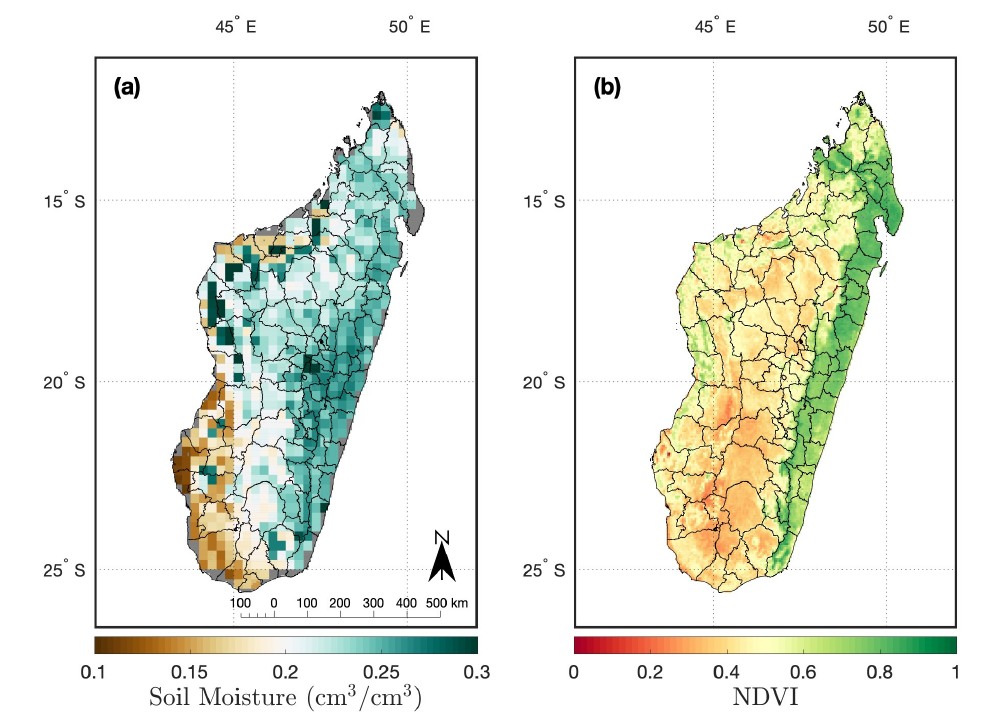
Figure 1. Satellite-based annual average ( a ) soil moisture and ( b ) vegetation activity (NDVI) from 2010 to 2017. Districts are outlined on each